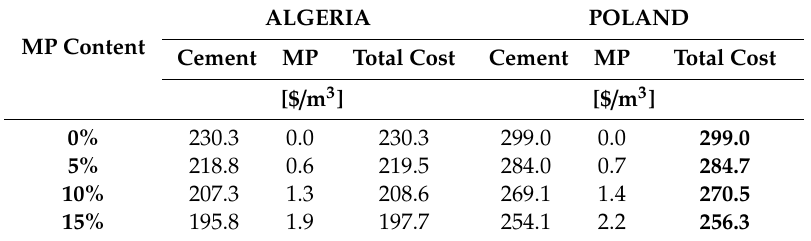
Table 6. The estimated costs of cement and MP used in analyzed cement paste and mortar (in $ / m 3 ). MP Content MP